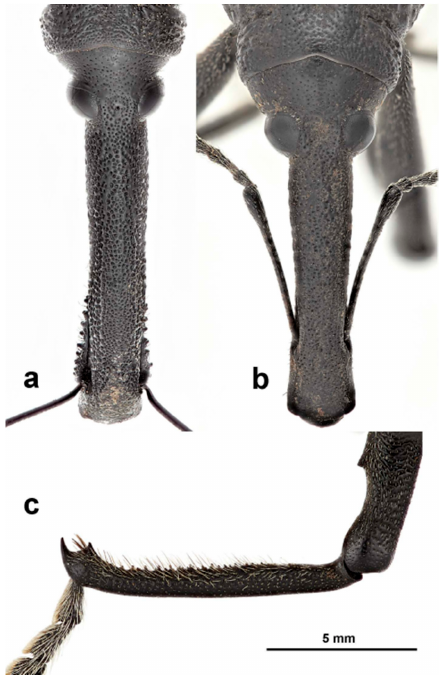
Figure 2. Vanapa oberthuri : ( a ) rostrum of male, dorsal aspect; ( b ) rostrum of female, dorsal aspect; ( c ) protibia of male, anterior aspect. Species included: Eurhamphus fasciculatus Shuckard, 1838 (Figures 3 and 4). Diagnosis : Body length (exclusive of head and rostrum) 21–33 mm. Body black, densely covered with creamy white to medium brown, appressed, elongate hair-like scales, some very long and erect